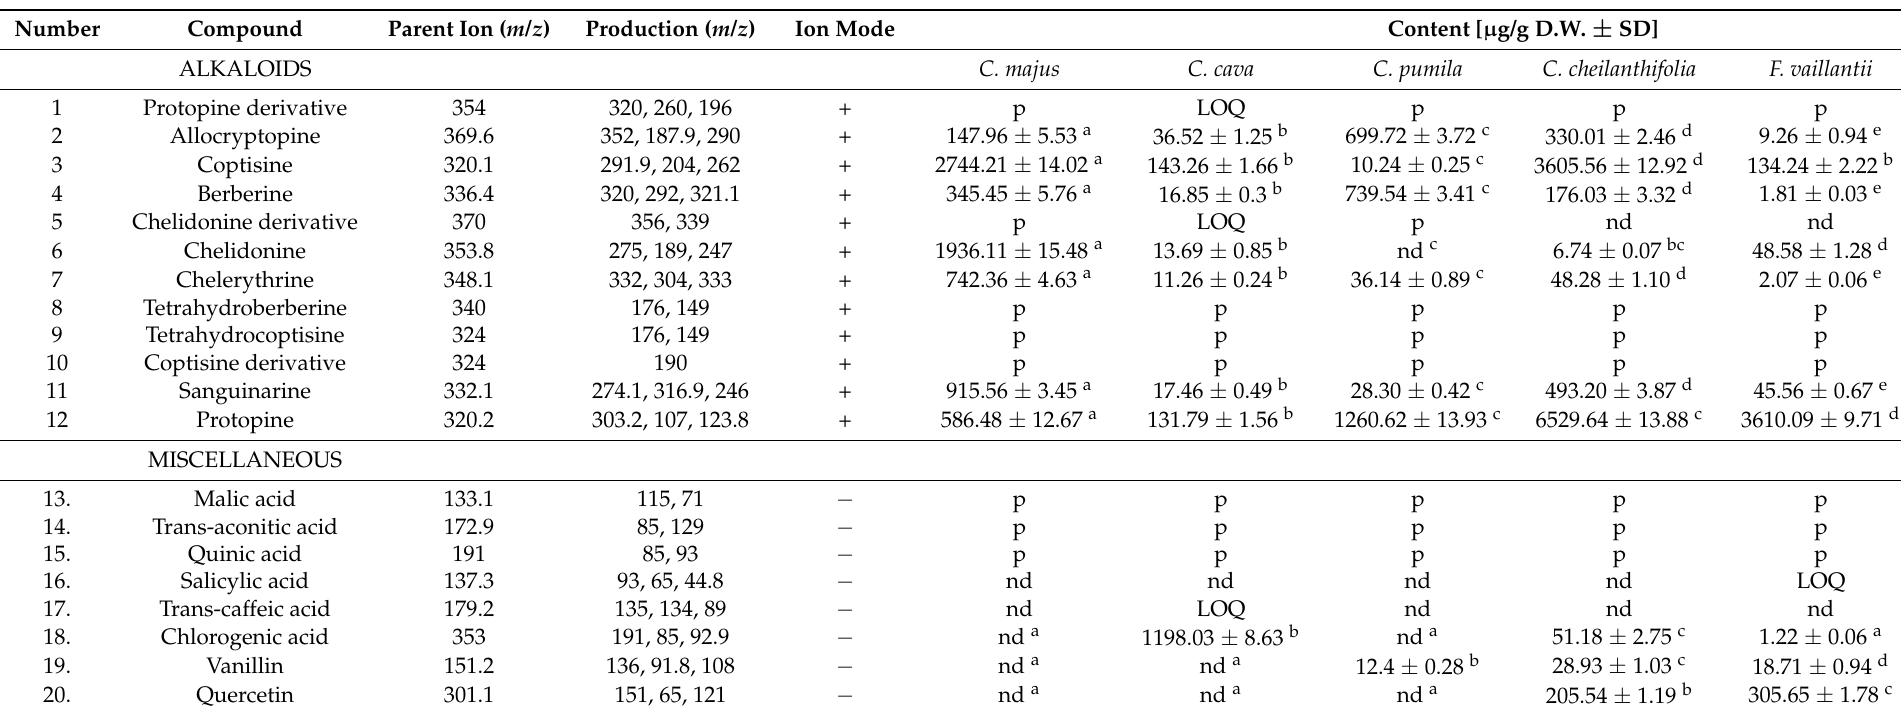
Table 2. Content [ µ g/g D.W. ± SD] of detected compounds in the underground parts of C. majus , C. cava , C. pumila , C. cheilanthifolia , and F. vaillantii